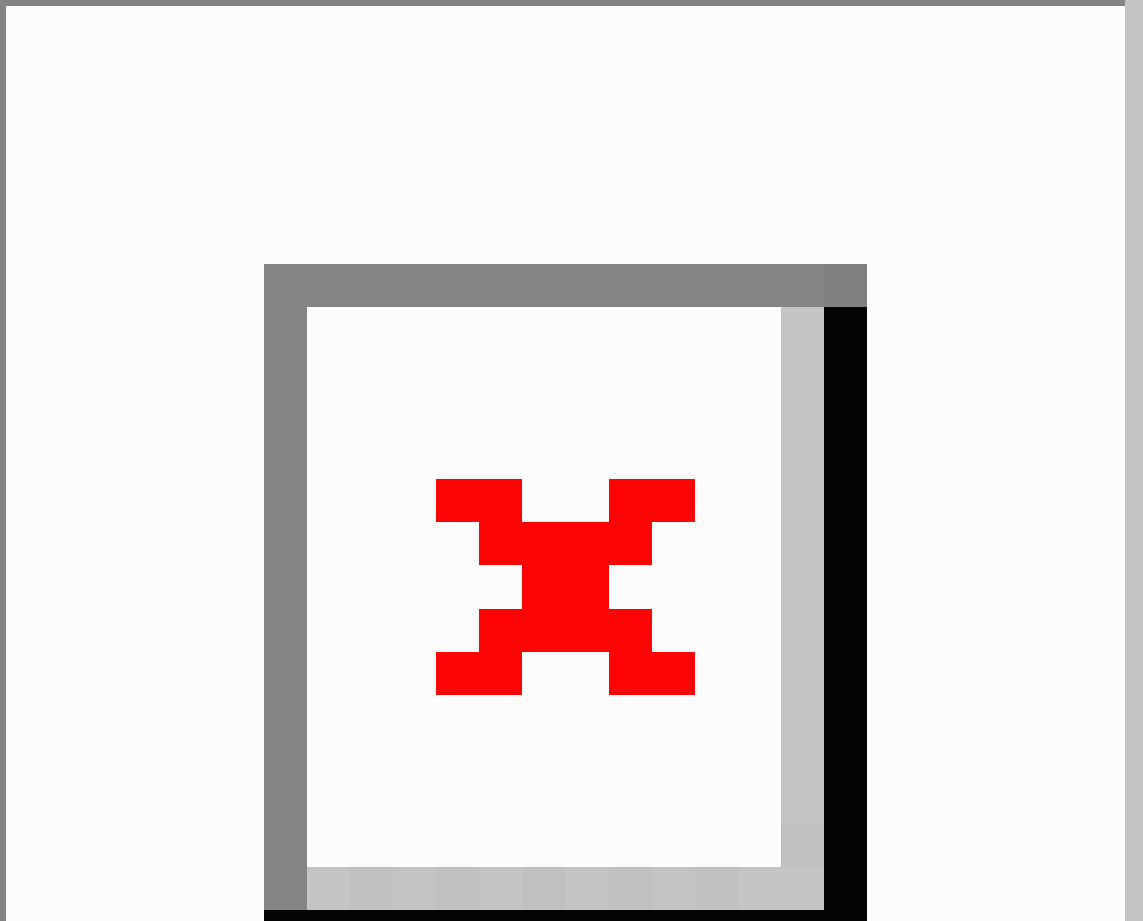
Figure 2. Screenshot of the QuitSTART app by the US Tobacco Control Research Branch at the National Cancer